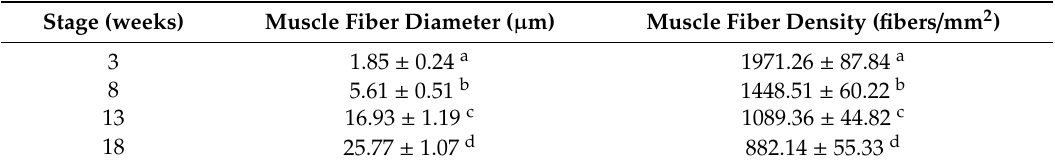
Table 3. The diameter and density of muscle fibers in breast tissue at di ff erent stages of development. Stage